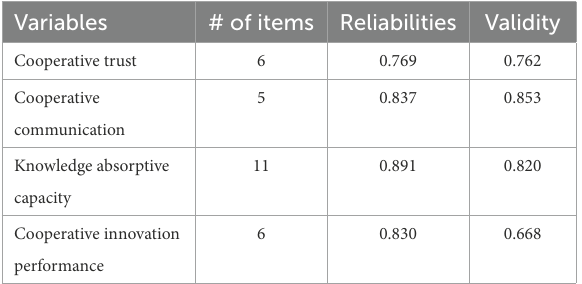
TABLE 2 Reliability and validity